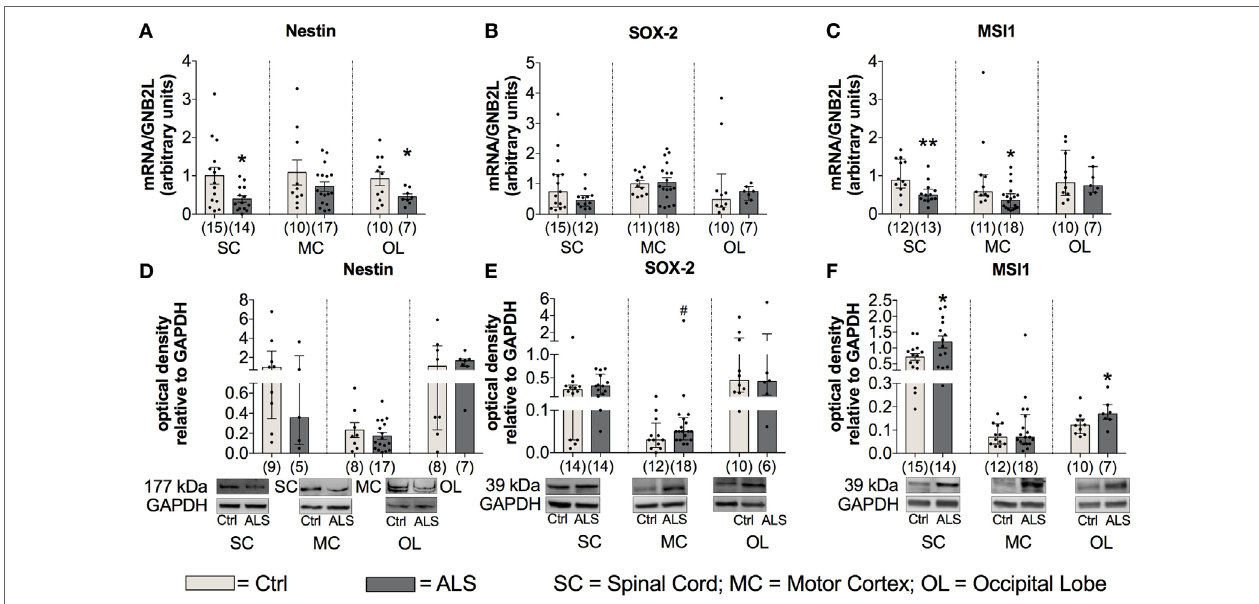
FigUre 10 | Tissue concentrations of neuronal stem cell markers are reduced in Amyotrophic lateral sclerosis (ALS) patients (a–F) . There was a reduced mRNA expression levels of Nestin within the spinal cord (SC) and the occipital lobe (OL) (a) , and decreased mRNA amounts of Musashi­1 (MSI1) within the SC and motor cortex (MC) (c) . Further, the protein expression of Nestin was unaffected in any of the three central nervous system (CNS) regions (D) . ALS patients exhibited a slight trend toward an enhanced SOX­2 protein expression within the motor cortex (MC) (e) and significant increased levels of MSI1 in the SC and OL (F) . * p < 0.05 vs. controls (Ctrl); ** p < 0.01 vs. Ctrl; # = trend, p = 0.09. Numbers of patients are given in brackets; all parameters were tested for Gaussian distribution using D’Augostino­Pearson omnibus normality test. Two­tailed Mann–Whitney test for MSI1 mRNA expression, MSI1 protein expression (MC, OL), data represent median with interquartile range. Two­tailed unpaired Student’s t ­test for Nestin mRNA expression in SC and OL, and for MSI1 protein expression in SC, data represent mean ± SEM. Nestin, SOX­2, and MSI1 protein expression levels were quantified and represented relative to the expression levels of the housekeeping protein GAPDH.